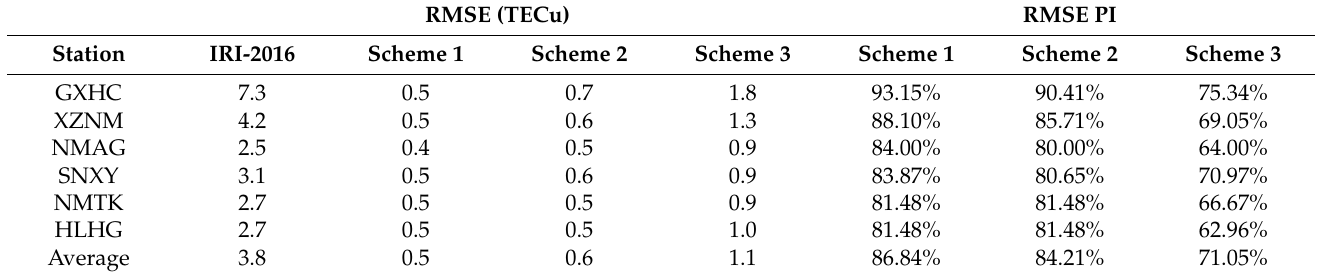
According to Table 1 (2015 statistical results) and Table 2 (2019 statistical results), scheme 1 yields the smallest average MAEs (0.4 TECu and 0.5 TECu, respectively) and average RMSEs (0.5 TECu and 1.0 TECu, respectively) among the various temporal